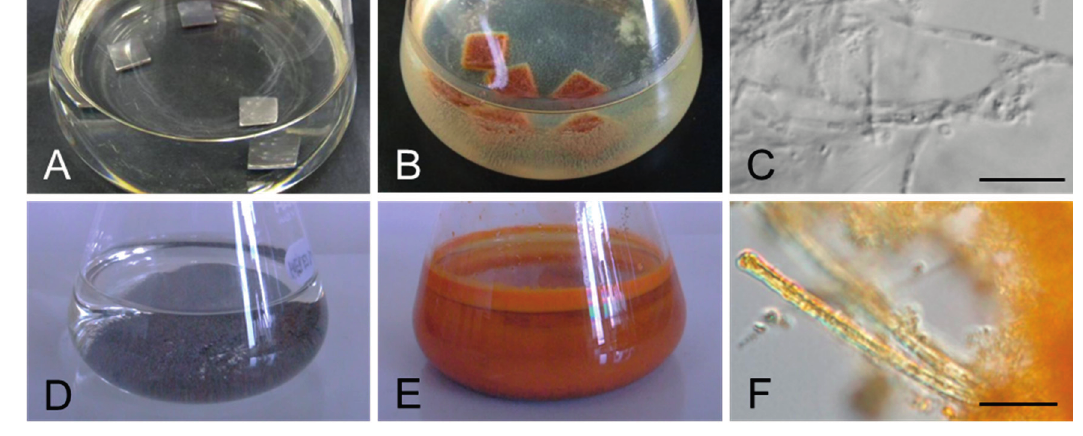
sheaths encompassing cells of Leptothrix sp. strain OUMS1 harvested from media after incubation. ( A ) Flask of Fe plate medium containing three Fe plates before incubation. ( B ) Brownish masses of Fe-encrusted sheaths cover the Fe plate surface, and whitish masses of primitive sheaths in the upper periphery of the medium after a 24 h incubation. ( C ) Light micrograph of primitive sheaths with thin, nearly transparent walls encompassing chained bacterial cells seen in the whitish mass at periphery of medium. ( D ) Flask of Fe powder medium containing 1.4 g/flask of 150 μ m Fe powders before incubation. ( E ) Brownish masses of Fe-encrusted sheaths on inner surface of flask in contact with shaken medium. ( F ) Light micrograph of Fe-encrusted sheaths with thick walls in brownish masses (E). Scale bar = 10 μ